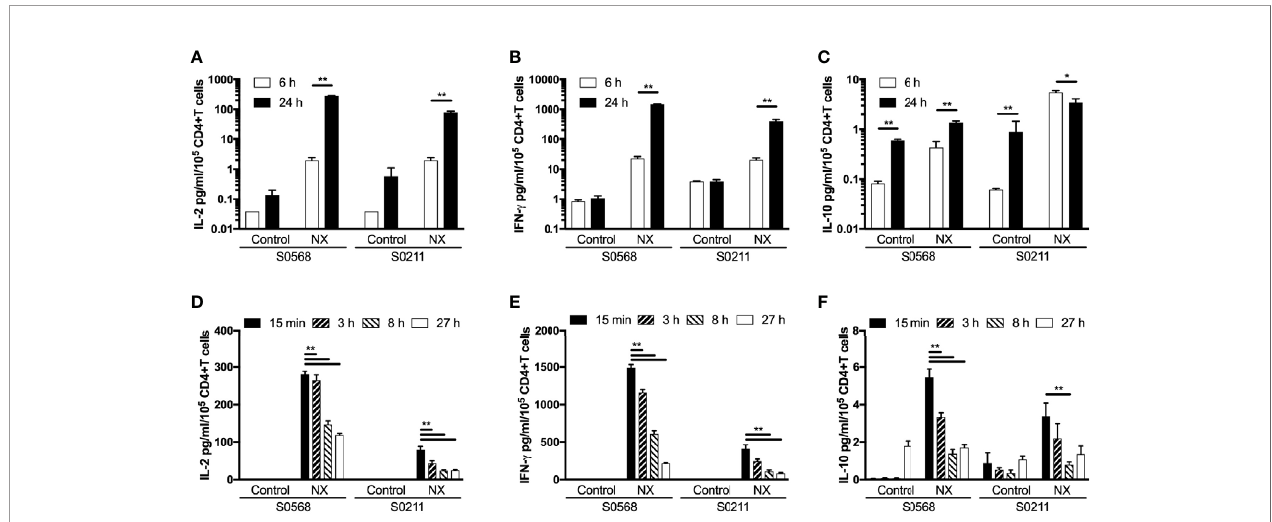
FIGURE 6 | Shortening the incubation period (A – C) , and varying the period blood was kept in collection tubes at room temperature (D – F) were assessed for their effects on gluten peptide-stimulated fresh whole blood IL-2, IFN- g , and IL-10 release. Blood samples from two HLA-DQ2.5+ CD patients collected after gluten challenge were studied. Bars represent the mean and SEM of six replicate wells. Statistical signi fi cance by Mann-Whitney U test *p < 0.05, **p <